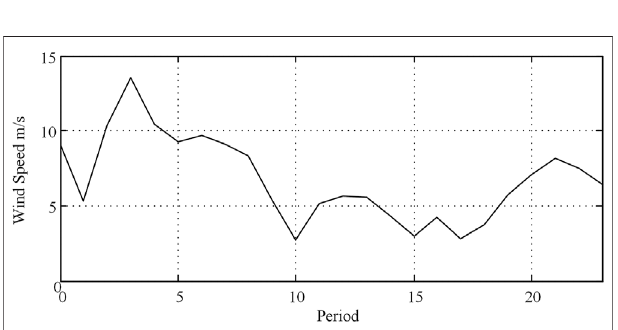
FIGURE 9 | Wind speed prediction